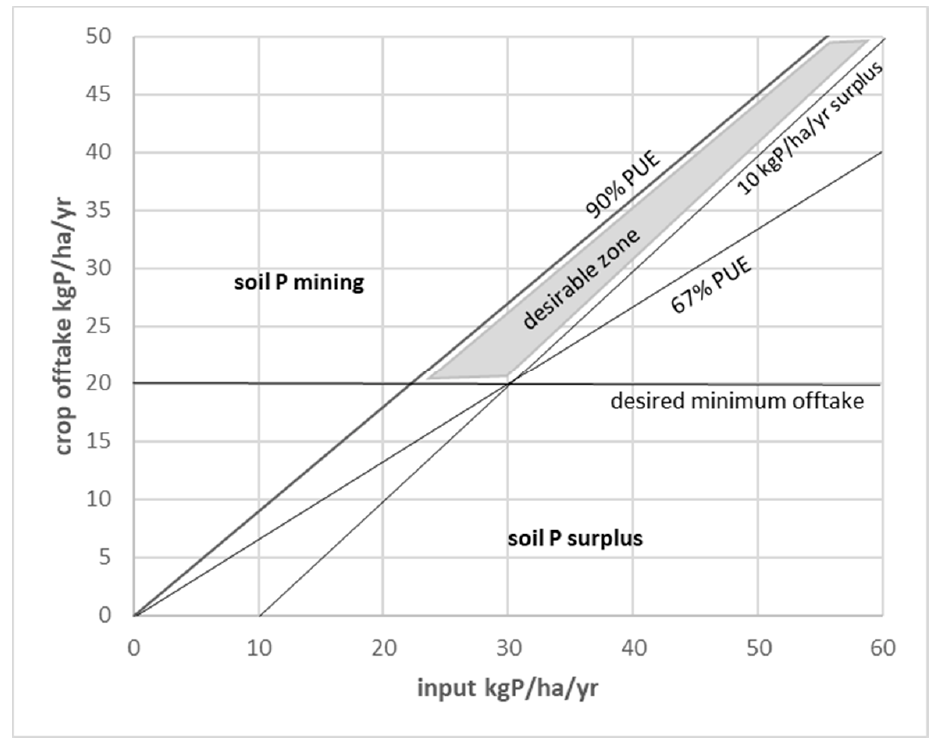
Figure 7. Graph depicting the total P input from manure and crop P offtake along with lines indicating 90% and 67% PUE and the 10 kgP/ha/year surplus line from the German Fertilizer Ordinance [66]. The “desirable” minimum offtake is only indicative as is the “desirable zone” of PUE and surplus. These would need to be estimated from case to case, depending on crop, soil, and local condi- tions.